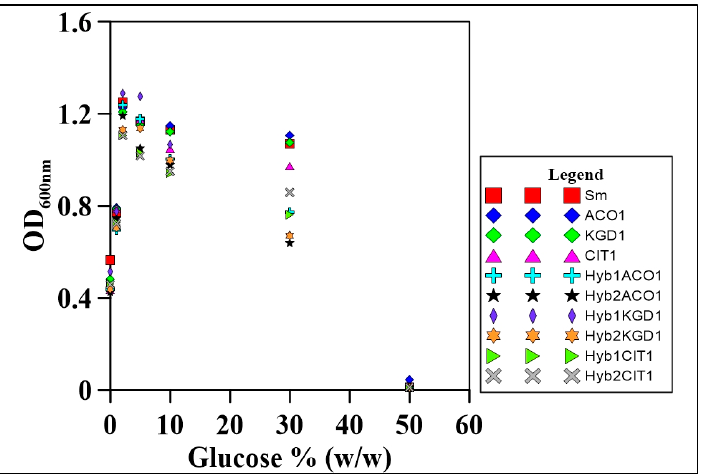
Figure 3. Osmotolerance of constructed hybrids and their parental strains S. mikatae ( Sm ) and S. cerevisiae ( ACO1 , KGD1 and CIT1 ).